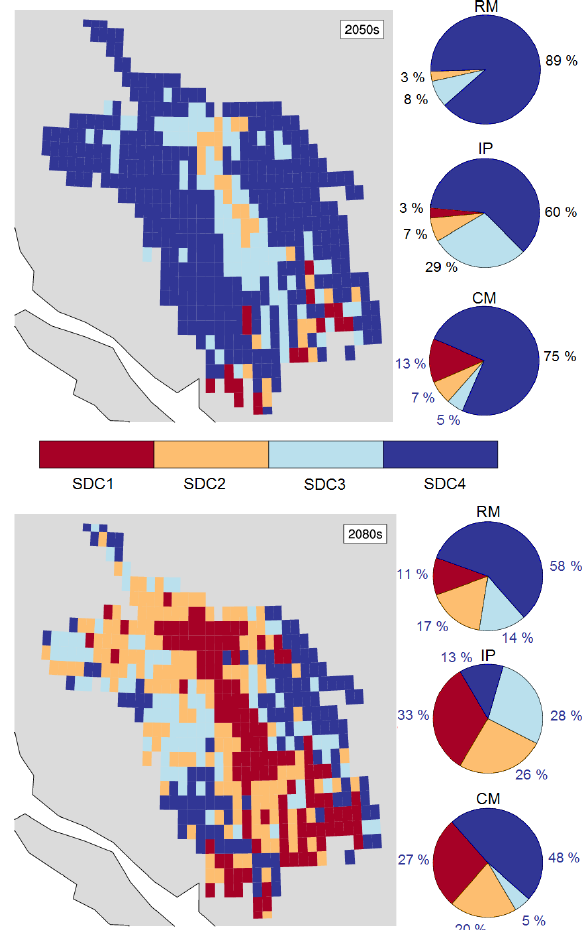
Figure 9. CMIP5-VIC-simulated MME mean projected snowmelt- dominant categories (SDC) in the 2050s and 2080s. SDCs are clas- sified using the SP detection algorithm (described in Sect. 2.5) and are based on changes (%) in the fraction of years with SP. Pie charts show corresponding change in fraction of grid cells (%) in each SDC for the geoclimatic regions of the Rocky Mountains (RM), In- terior Plateau (IP) and Coast Mountains